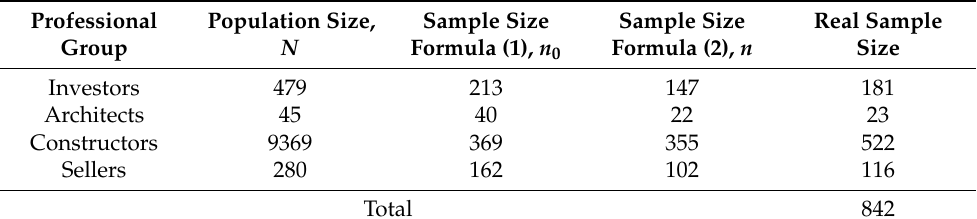
Table 1. Population size, the sample size for finite population, the sample size for the small popula- tion, and real sample size divided into the researched professional